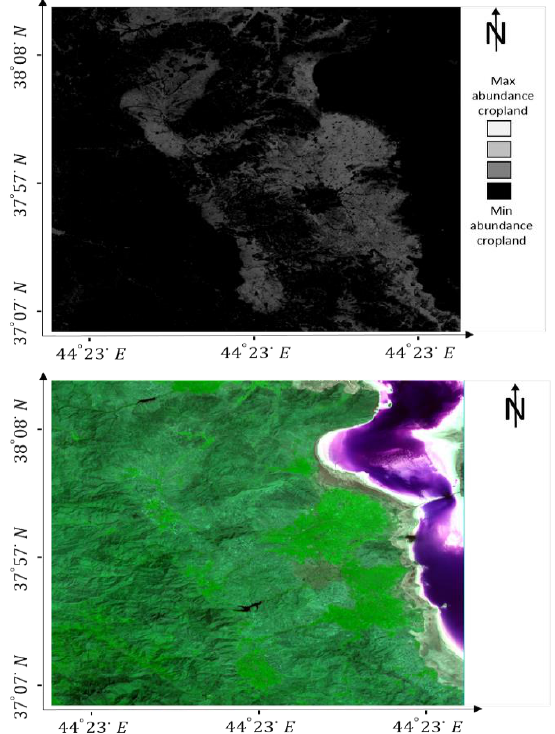
Figure (3). Map of cropland (CP) and an NDVI image of the PROBA-V related to Urmia city